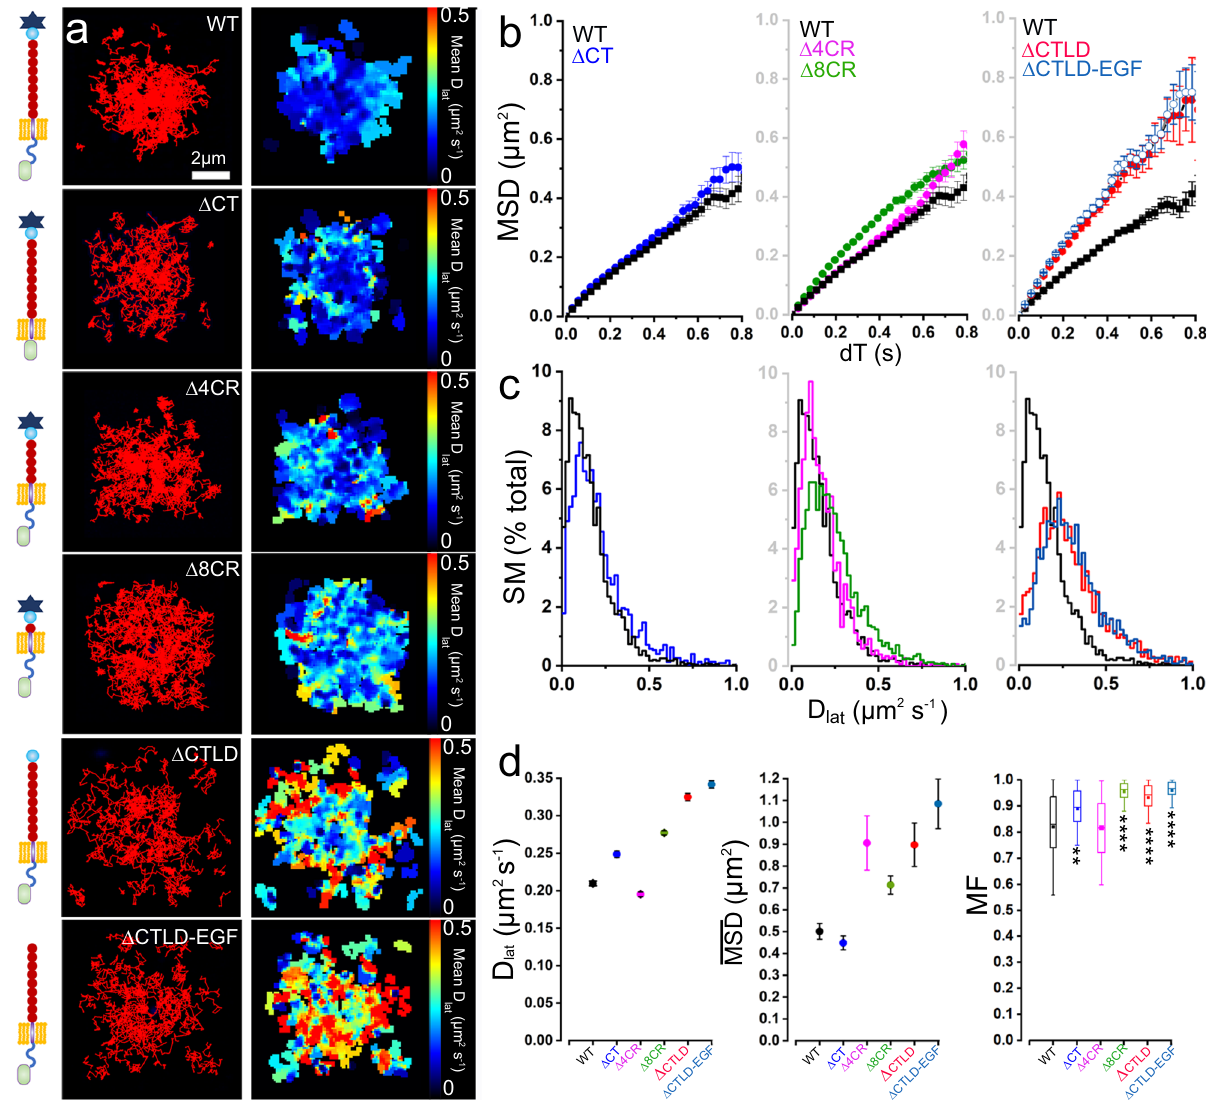
Fig. 2 Deletion of CTLD increases P-selectin mobility at exocytosis sites. a SM trajectories detected at WPB exocytosis sites immediately after histamine stimulation (left panels) shown for different deletion mutants. Video records were aligned and concatenated as described in Fig. 1b. From top: Full-length P- selectin-eGFP (WT) (165 SMs, n = 9 fusion events), Δ CT (174 SMs n = 5 events), Δ 4CR (265 SMs, n = 5 events), Δ 8CR (187 SMs, n = 5 events), Δ CTLD (170 SMs, n = 4 events), and Δ CTLD-EGF (146 SMs, n = 3 events). Scale bar applies to all images. Tracks are pseudo-colored to report mean lateral diffusion coef fi cient ( D lat ) over track duration (right panels) . b MSD vs dT plots (as for Fig. 1e) for mutants compared to WT (black data, replicated in the plots to ease comparison). c D lat distributions for mutants compared to WT (black data). For b , c Δ CT (blue; 2244 SMs, n = 41 fusion events, n = 15 cells, three experiments); Δ 4CR (magenta; 1502 SMs, 72 fusion events, n = 28 cells, three experiments); Δ 8CR (green; 3907 SMs, 50 fusion events, n = 19 cells, three experiments); Δ CTLD (red; 872 SMs, 57 fusion events, n = 12 cells, three experiments) and Δ CTLD-EGF (dark blue; 1569 SMs, 37 fusion events, n = 8 cells, three experiments). d Fitted values of D fi dence interval) and limiting MSD (MSD) (±95% con fi dence interval). Mobile fraction, lat (±95% con MF, (de fi ned as molecules with D lat > 0.05 µ m 2 s − 1 ) plotted as Box and Whiskers (as de fi ned in Fig. 1). Results of one-way ANOVA, multiple